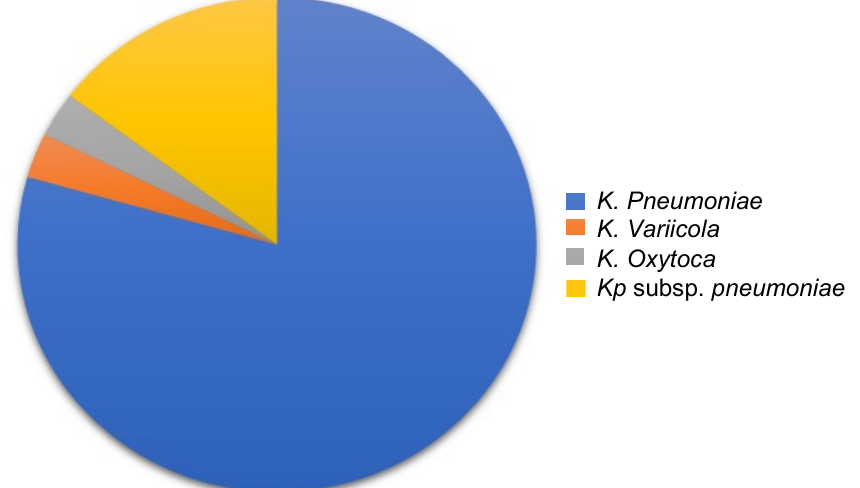
Figure 3. The distribution of ClpK proteins found among the investigated Klebsiella species. The total number of ClpK was tallied from data obtained using the NCBI Genome database. The highest number of ClpK was found in K. pneumoniae (27 strains), followed by Kp subsp. pneumoniae (5 strains), K. variicola (1 strain) and K. oxytoca (1 strain).